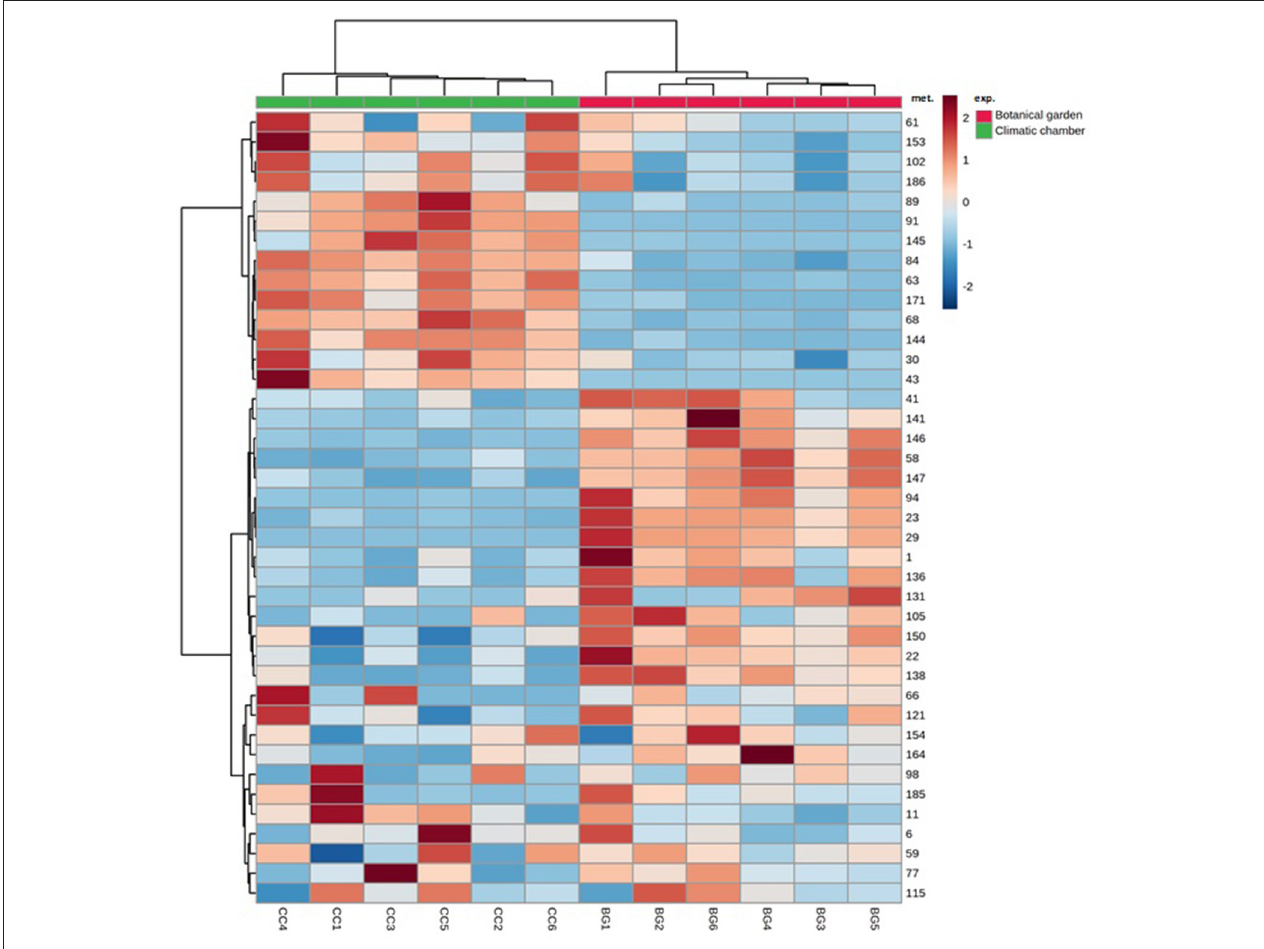
FIGURE 3 | Hierarchical clustering heat maps of differentially abundant polyphenols between BG and CC treatments. For each treatment, six replicates (1–6) were performed. Significant differences were found via Student’s t -test. Red: botanical garden, green: climatic chamber. The numbers in the heat maps correspond to